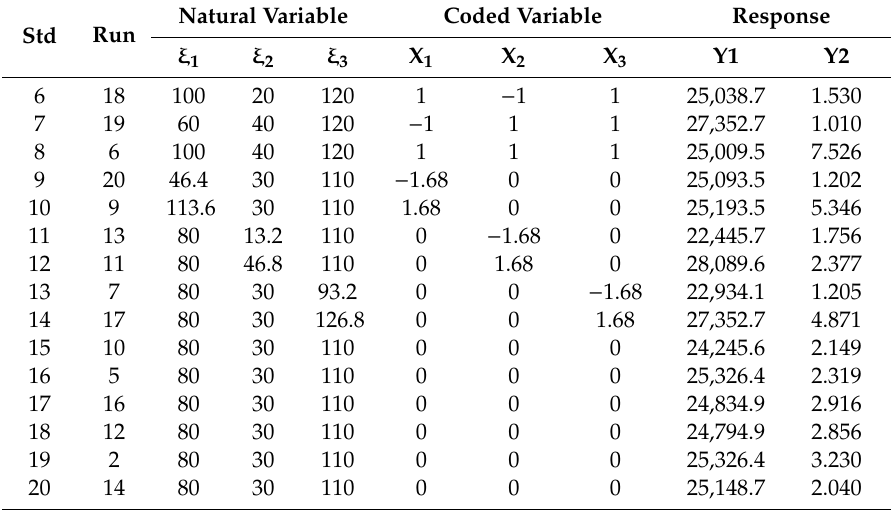
Table 4. Summary of the F - Value for each response variable.